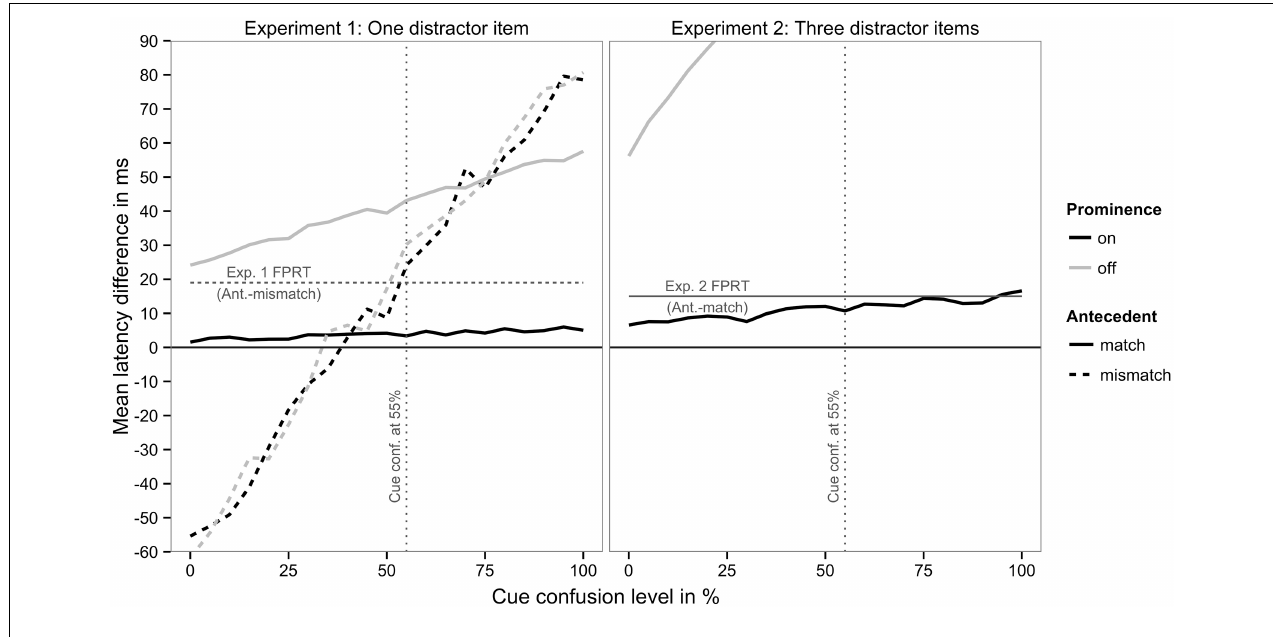
FIGURE 2 | Predicted interference effect (distractor-match − distractor-mismatch) by cue confusion level for the default model (gray lines) and the prominence model (black lines). The left panel shows the predicted interference for a single distractor (Exp. 1); the right panel for three distractors (Exp. 2). Solid lines represent the conditions where the antecedent matches the semantic cue,